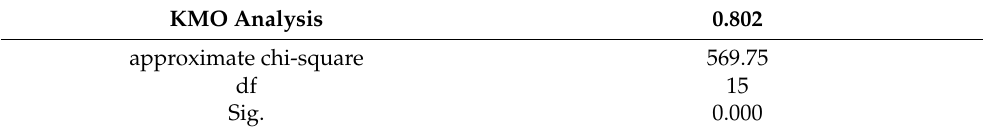
Table 3. Chi-square test satisfaction factor.